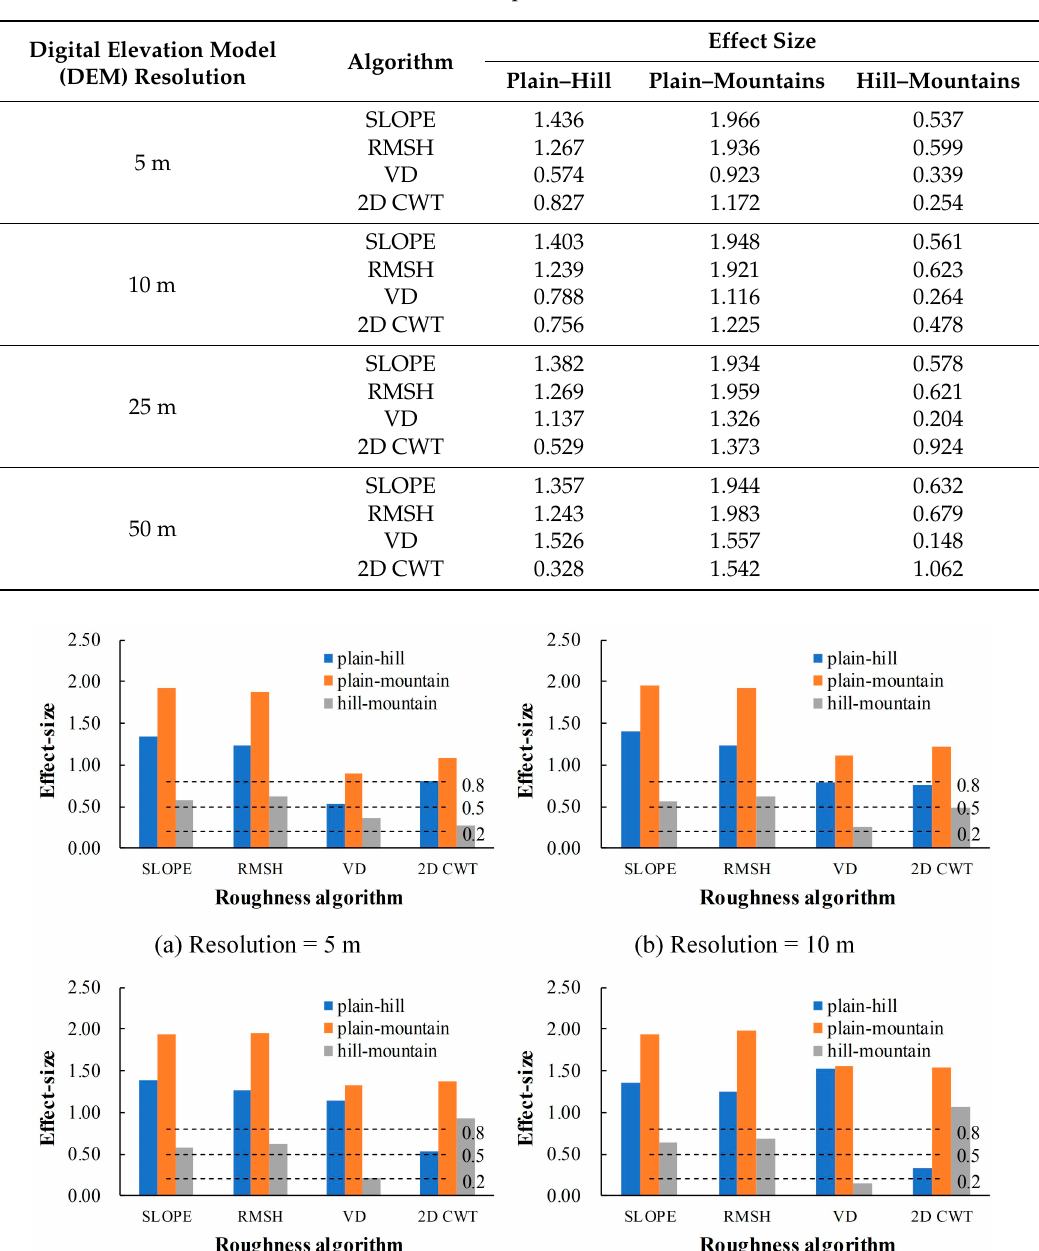
Table 3. Comparison of ES.